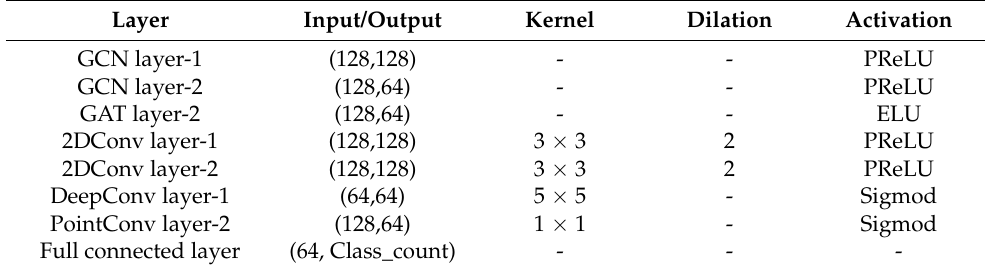
Table 1. Detailed configuration of the proposed network